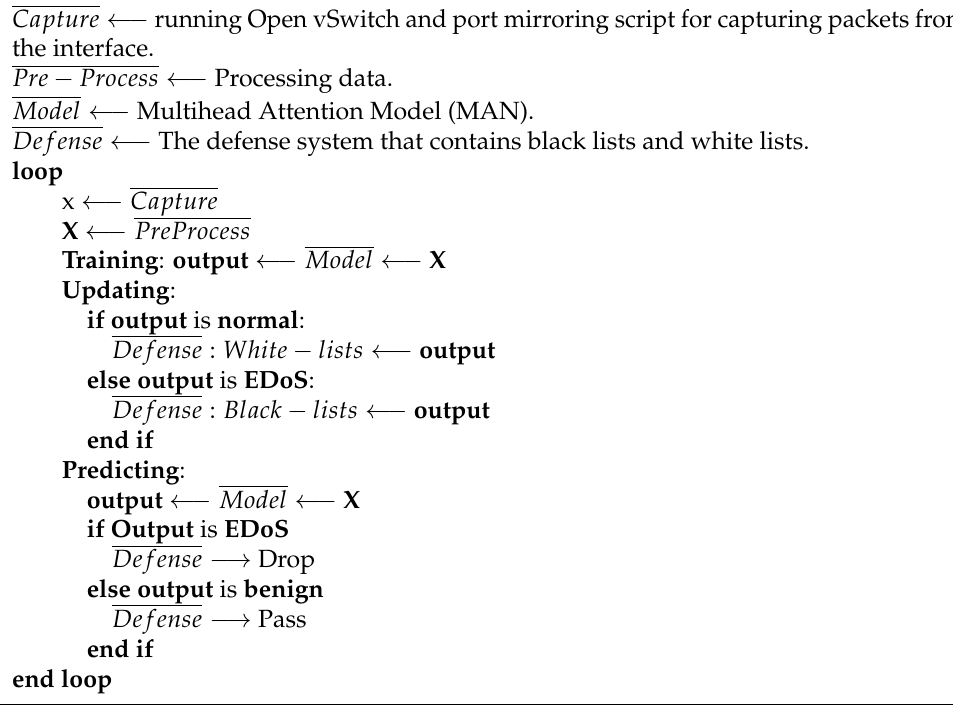
Figure 5. Testbed set up for capturing network packets. Algorithm 1 Workflow of testbed for EDoS detection and